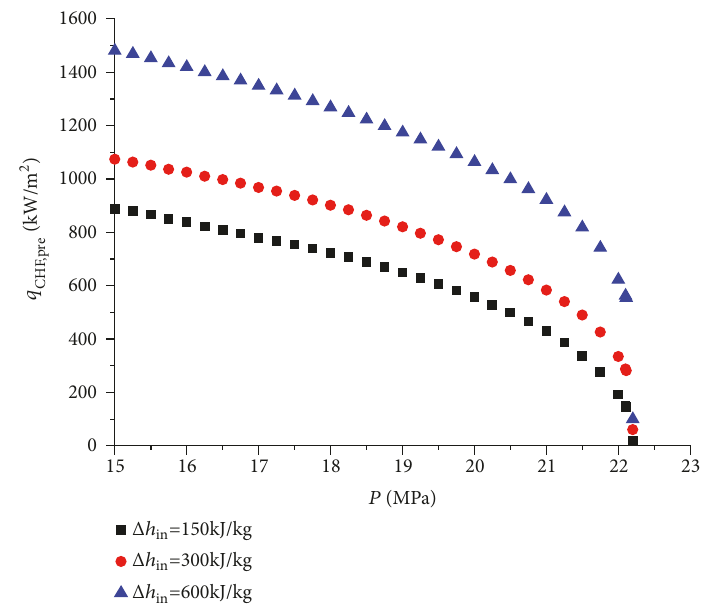
Figure 10: CHF as a function of pressure ( G =1000kg/m 2